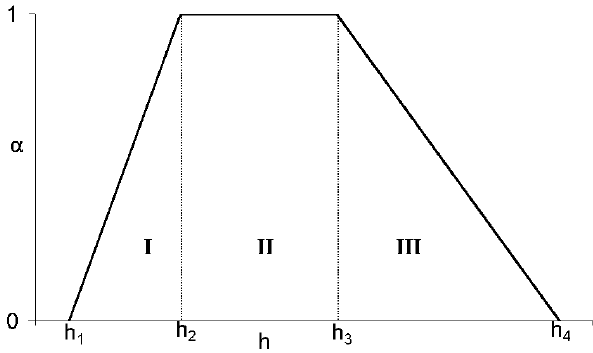
Fig. 1. Root water uptake reduction function, as implemented in SWAP, after van Dam et al.